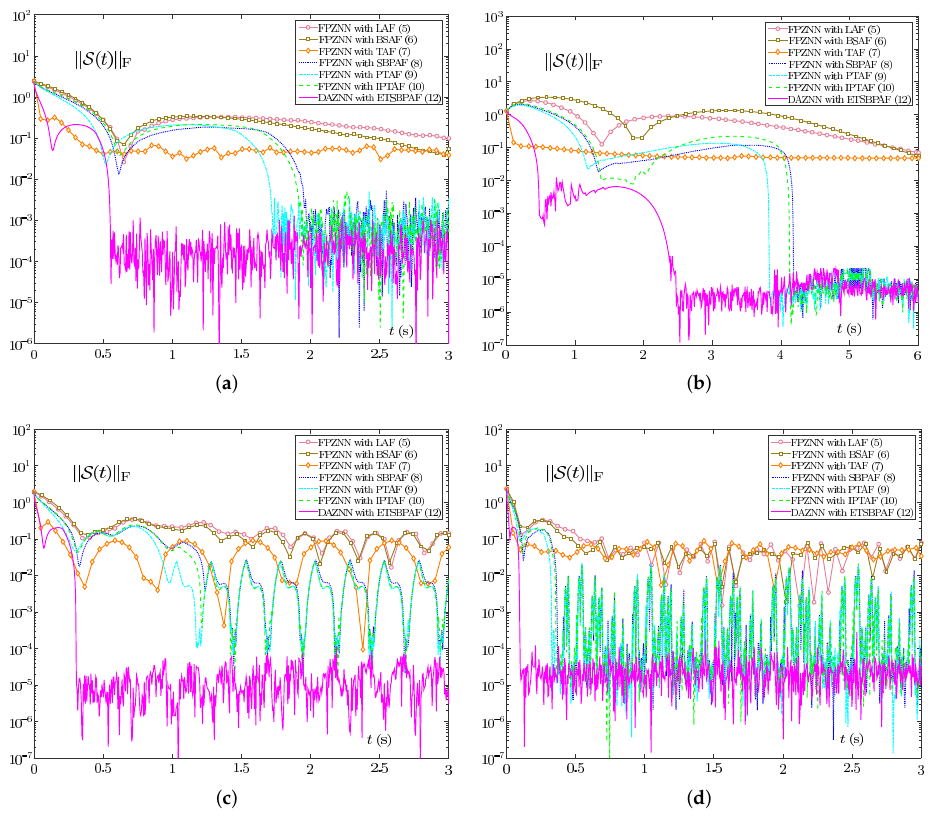
Figure 5. Dynamic characteristics of the (cid:107)S ( t ) (cid:107) F by FPZNN model (4) and DAZNN model (14) with disparate bounded noises and different λ 1 , λ 2 . ( a ) Gaussian noise and λ 1 = λ 2 = 1.5. ( b ) Ex- ponentially attenuated noise ξ ij ( t ) = exp ( − 1.2 t + 2 ) and λ 1 = λ 2 = 1.5. ( c ) Harmonic